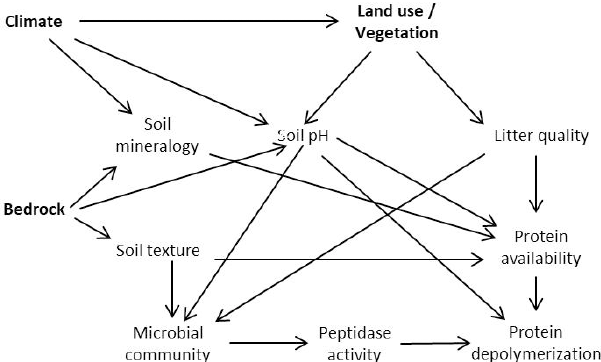
Figure 1. Proposed model relating climate, bedrock and land use effects to protein depolymerization